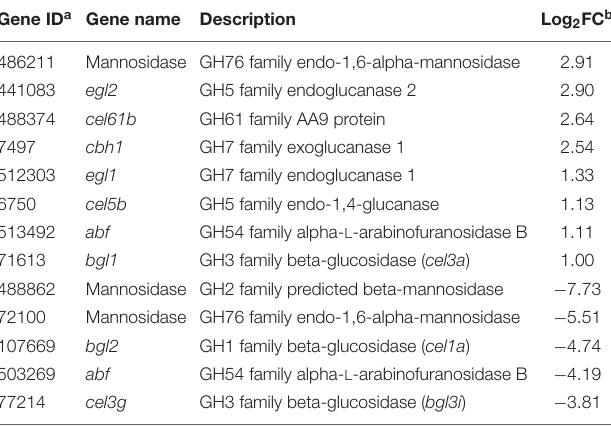
TABLE 1 | Enzymatic activities of the isolated cellulolytic fungal strains from Tibet*. Genus